Question: Author a descriptive caption for the visualization shown.
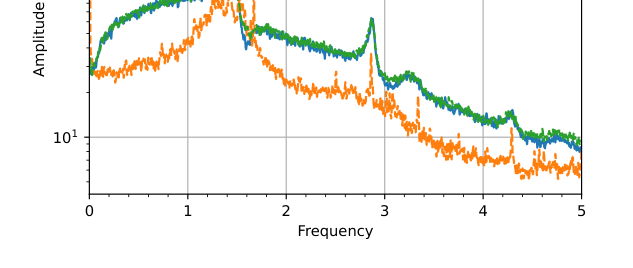
Answer: Fourier Spectrum of a predicted time series in the closed- loop configuration with a reservoir size of N = 30. The true system is depicted as a solid blue line, while the classic linear regression and the attention-enhanced reservoir are shown as dashed orange and green lines, respectively